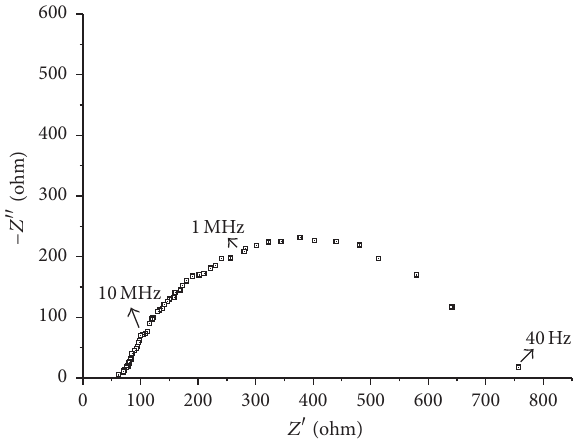
Figure 4: High-frequency range Nyquist plot of typical concrete.